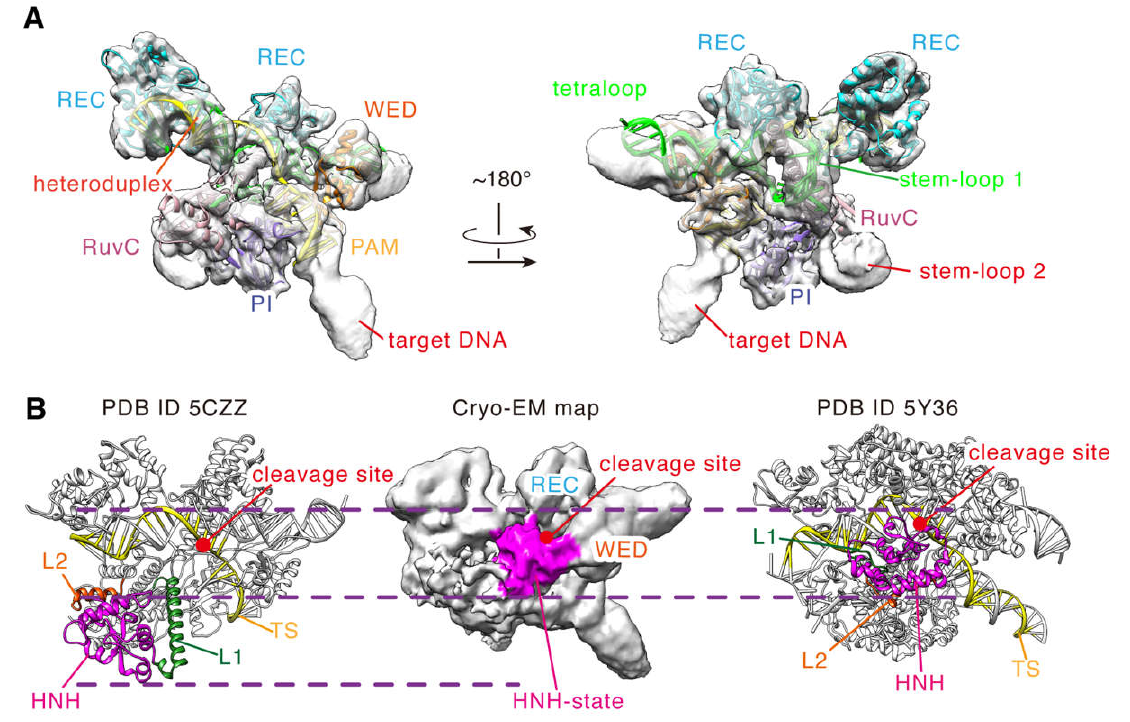
Figure 3. The conformational state of the cryo-EM density map. ( A ) Rigid-body fitting of the crystal structure (PDB ID 5CZZ) with the cryo-EM density map (contour level = ~0.0047). The structure of 5CZZ is shown by cartoon. ( B ) Comparison of the conformational states of the HNH domain in the density map (contour level = ~0.0022) with those of PDB ID 5CZZ and 5Y36. The dashed lines indicate the boundaries of the HNH domains.